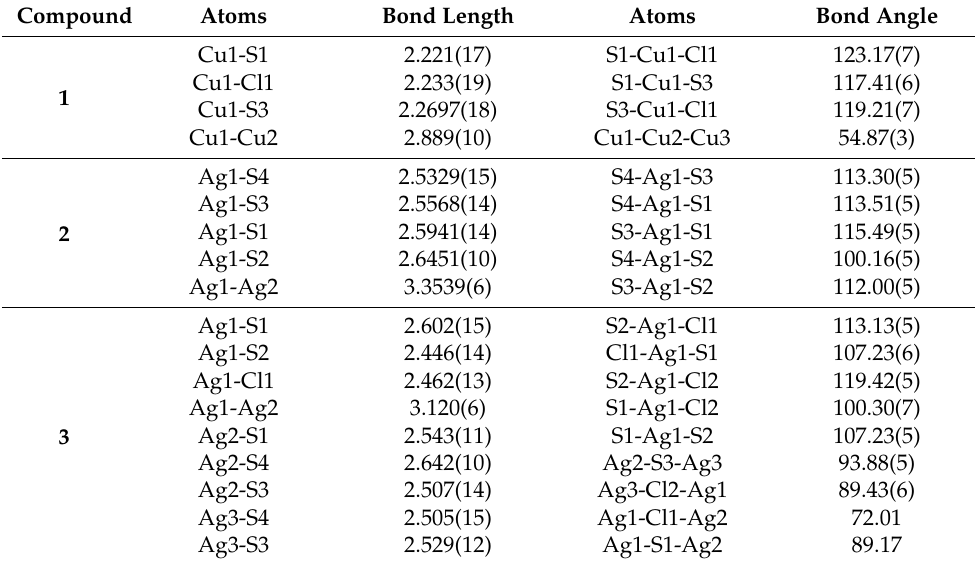
Figure 12. Two-dimensional fingerprint plots for all intermolecular contacts in 2 . The percentage of contribution is specified for each contact. Table 1. List of selected bond lengths (Å) and bond angles ( o ) of compound 1 – 3 .